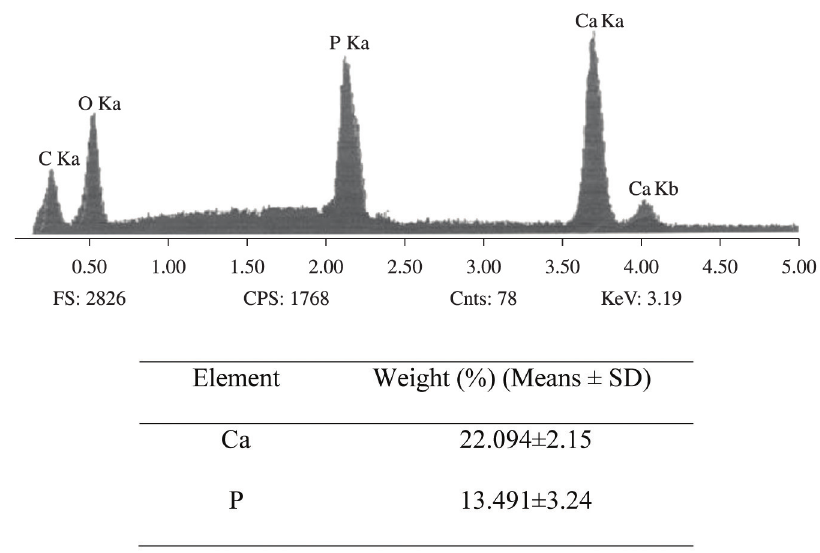
Figure 6. Energy dispersive X-ray analysis on MC3T3-E1 cells cultured together with collagen microspheres encapsulating steroidal saponins at 10 days post differentiation. The mean values with standard deviations (SDs) for the relative composition of calcium and phosphorus are shown in the lower